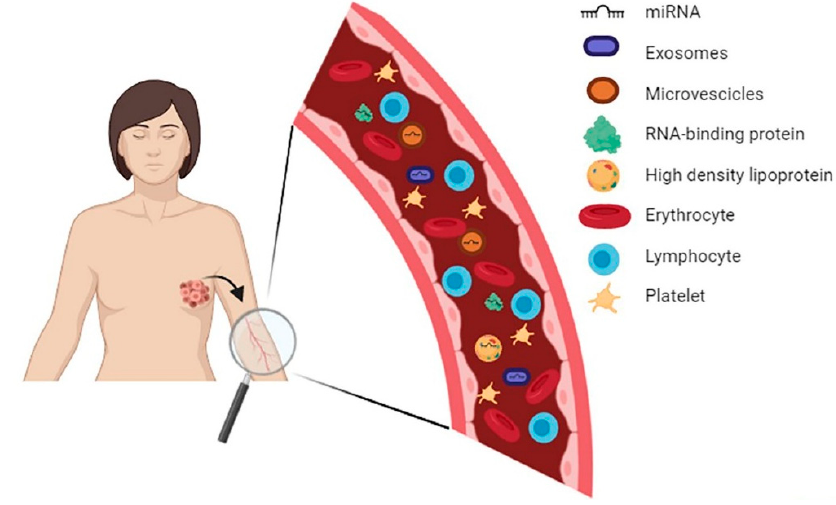
Figure 2. Schematic representation of miRNA release from tumor to bloodstream and compartmentalization of circulating miRNAs.